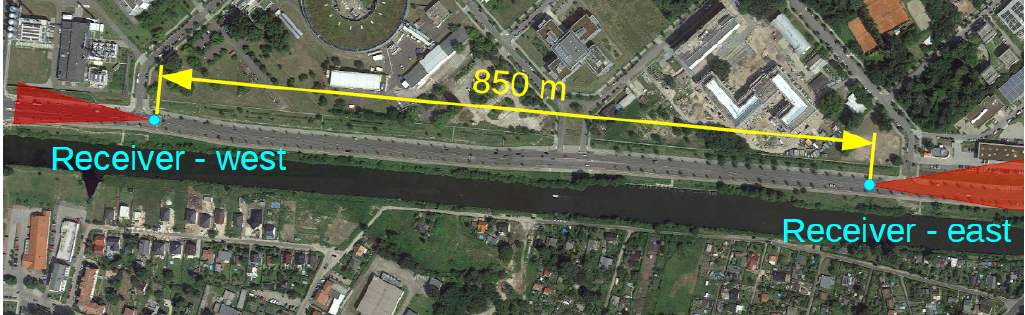
Figure 1: UTRaLab and its two